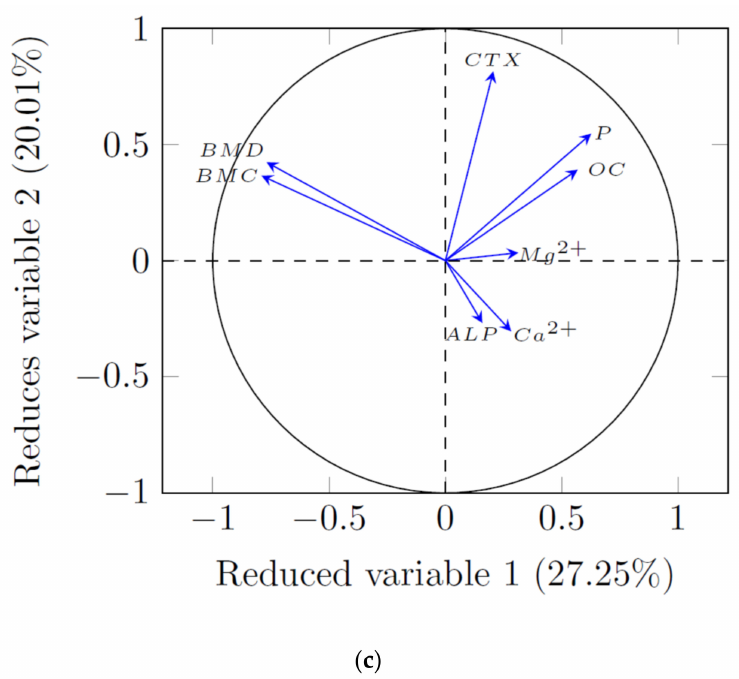
Figure 3. ( a ) Principal component analysis (second version, option 1) with distribution of analyzed parameters (validation model). ( b ) Principal component analysis (second version, option 2) with distribution of analyzed parameters (LC groups). ( c ) Principal component analysis (second version, option 3) with distribution of analyzed parameters (all experimental groups).